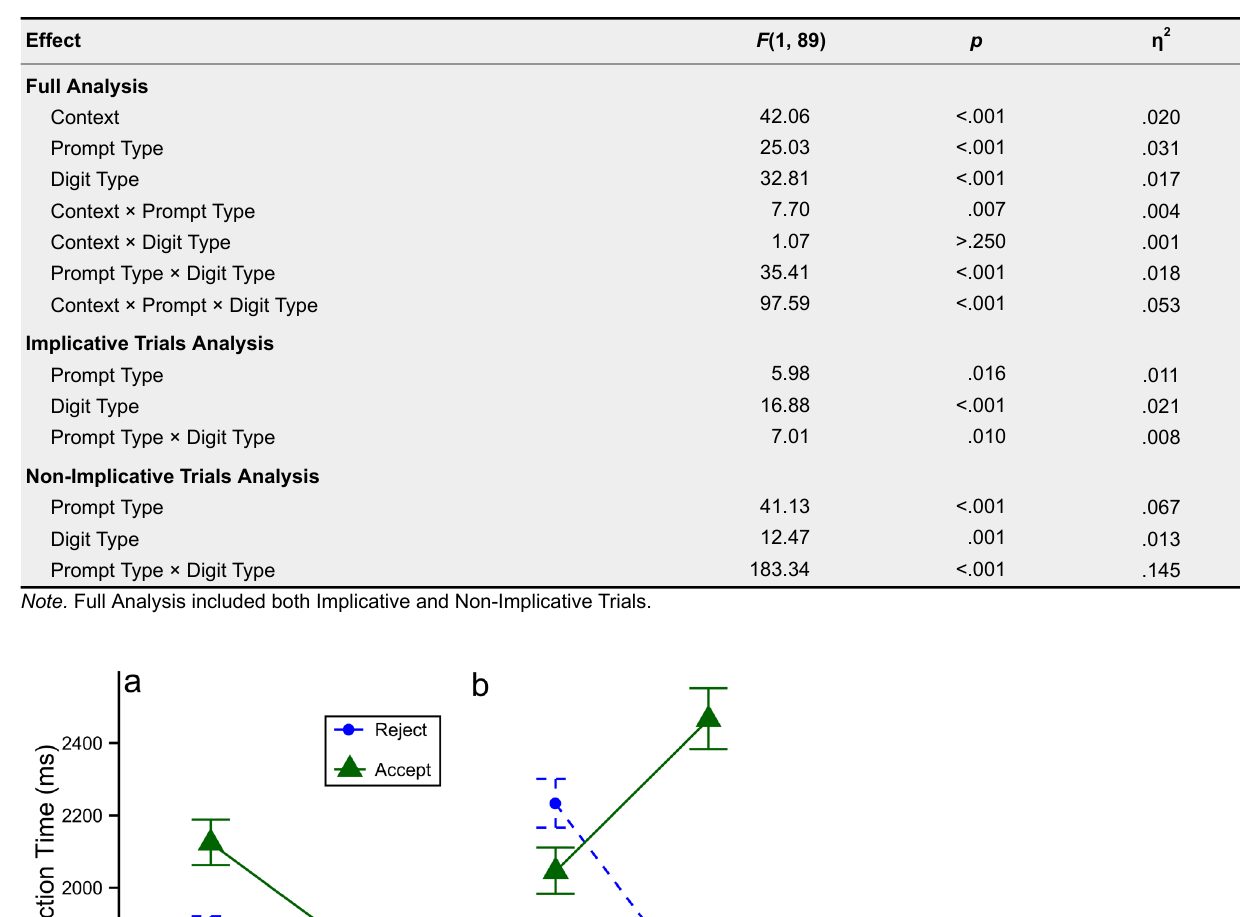
Repeated Measures Analysis of Variance of the Effects of Different Contextual Stimuli in the Sentence Verification Task